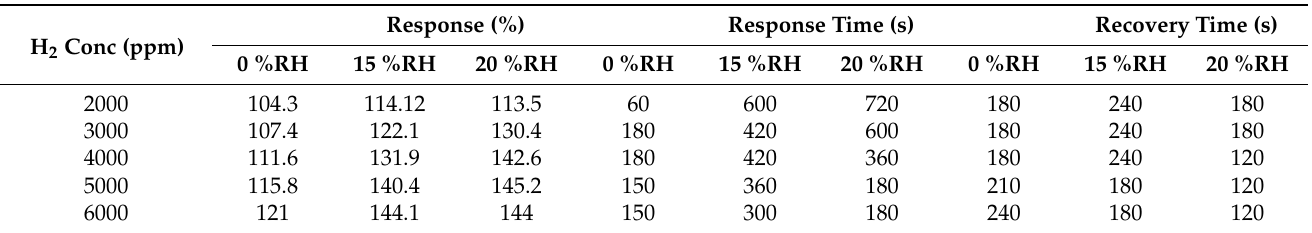
Table 3. Sensing parameters towards H 2 with 2000–6000 ppm concentrations at 150 ◦ C under UV